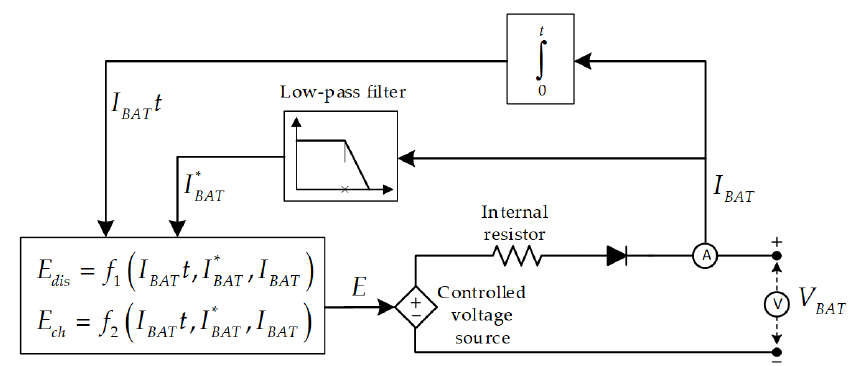
Figure 3. Polarization curves of the PEMFC stack.